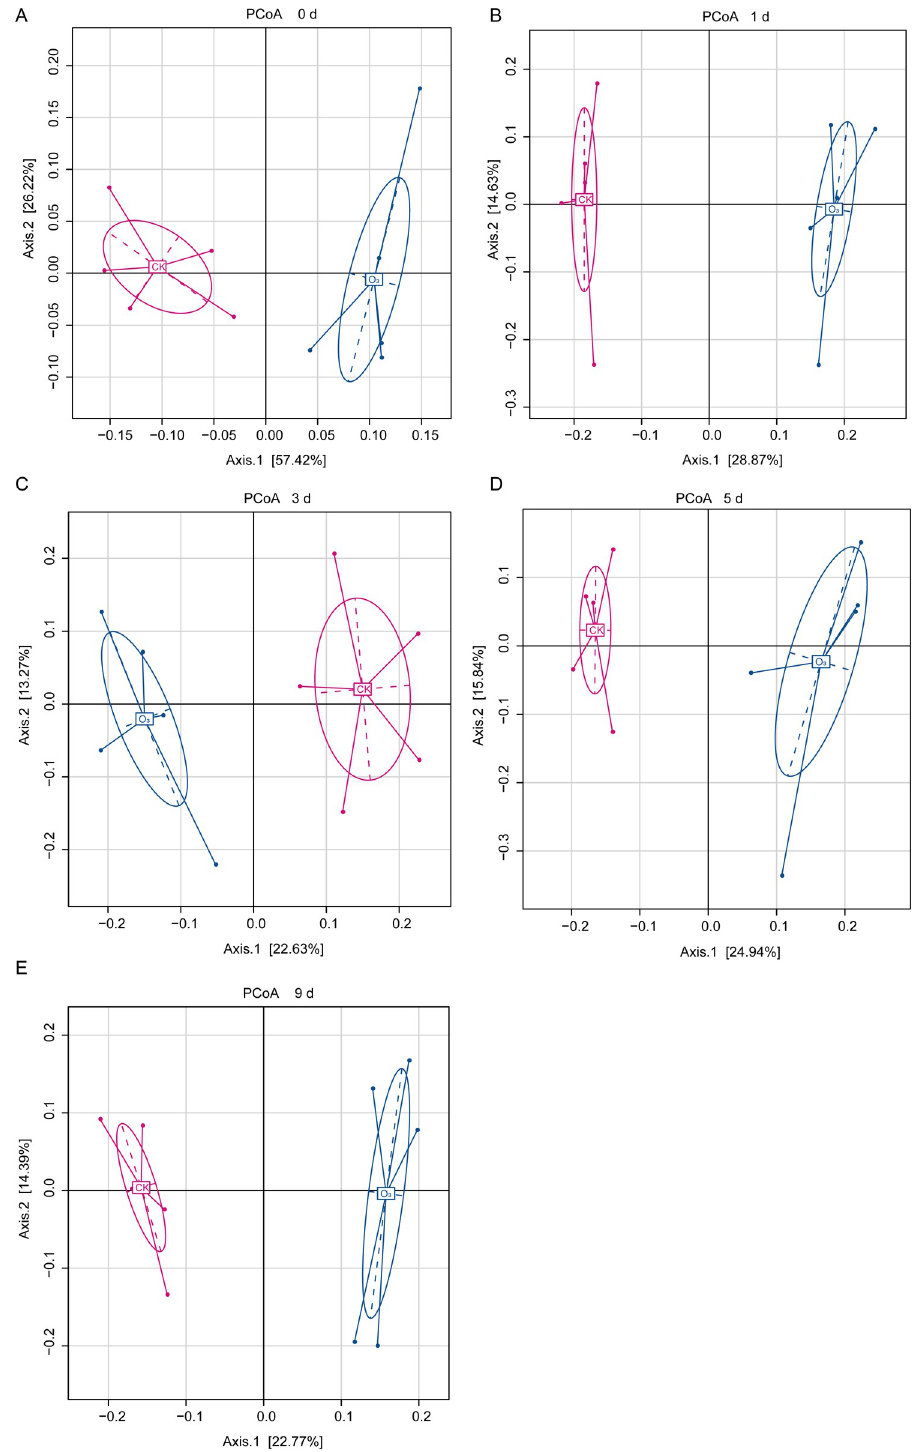
Fig 2. Microbial community principal coordinate analysis (PCoA) of the CK group and O 3 group. (A-E) The PCoA results at 0, 1, 3, 5 and 9 days.